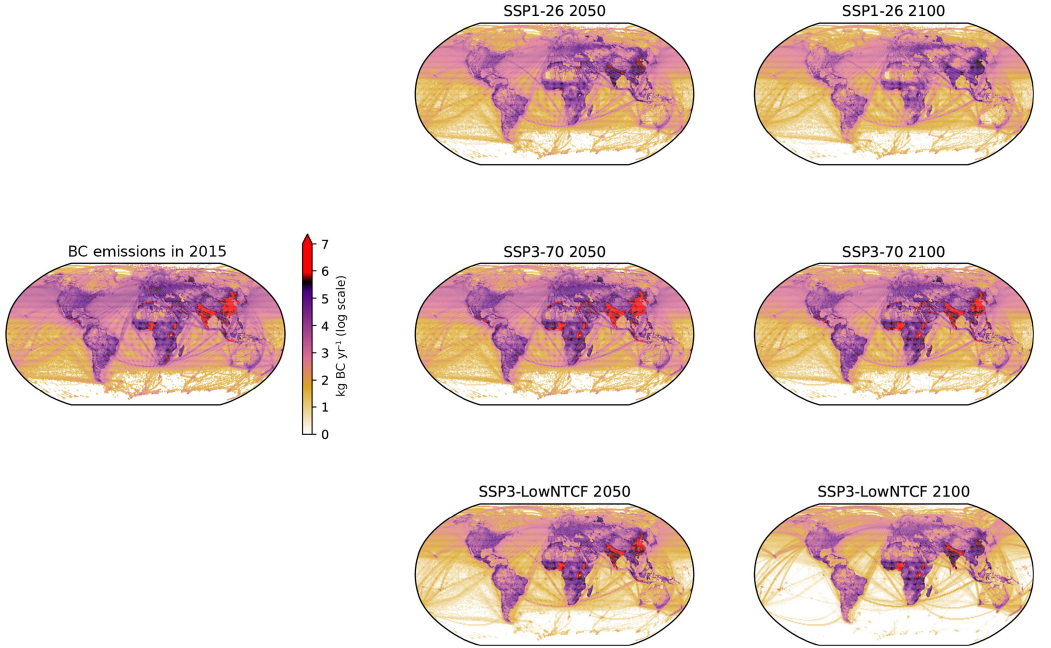
Figure 9. Downscaled and gridded emissions of black carbon at present and in 2050 and 2100 for SSP1-2.6, SSP3-7.0, and